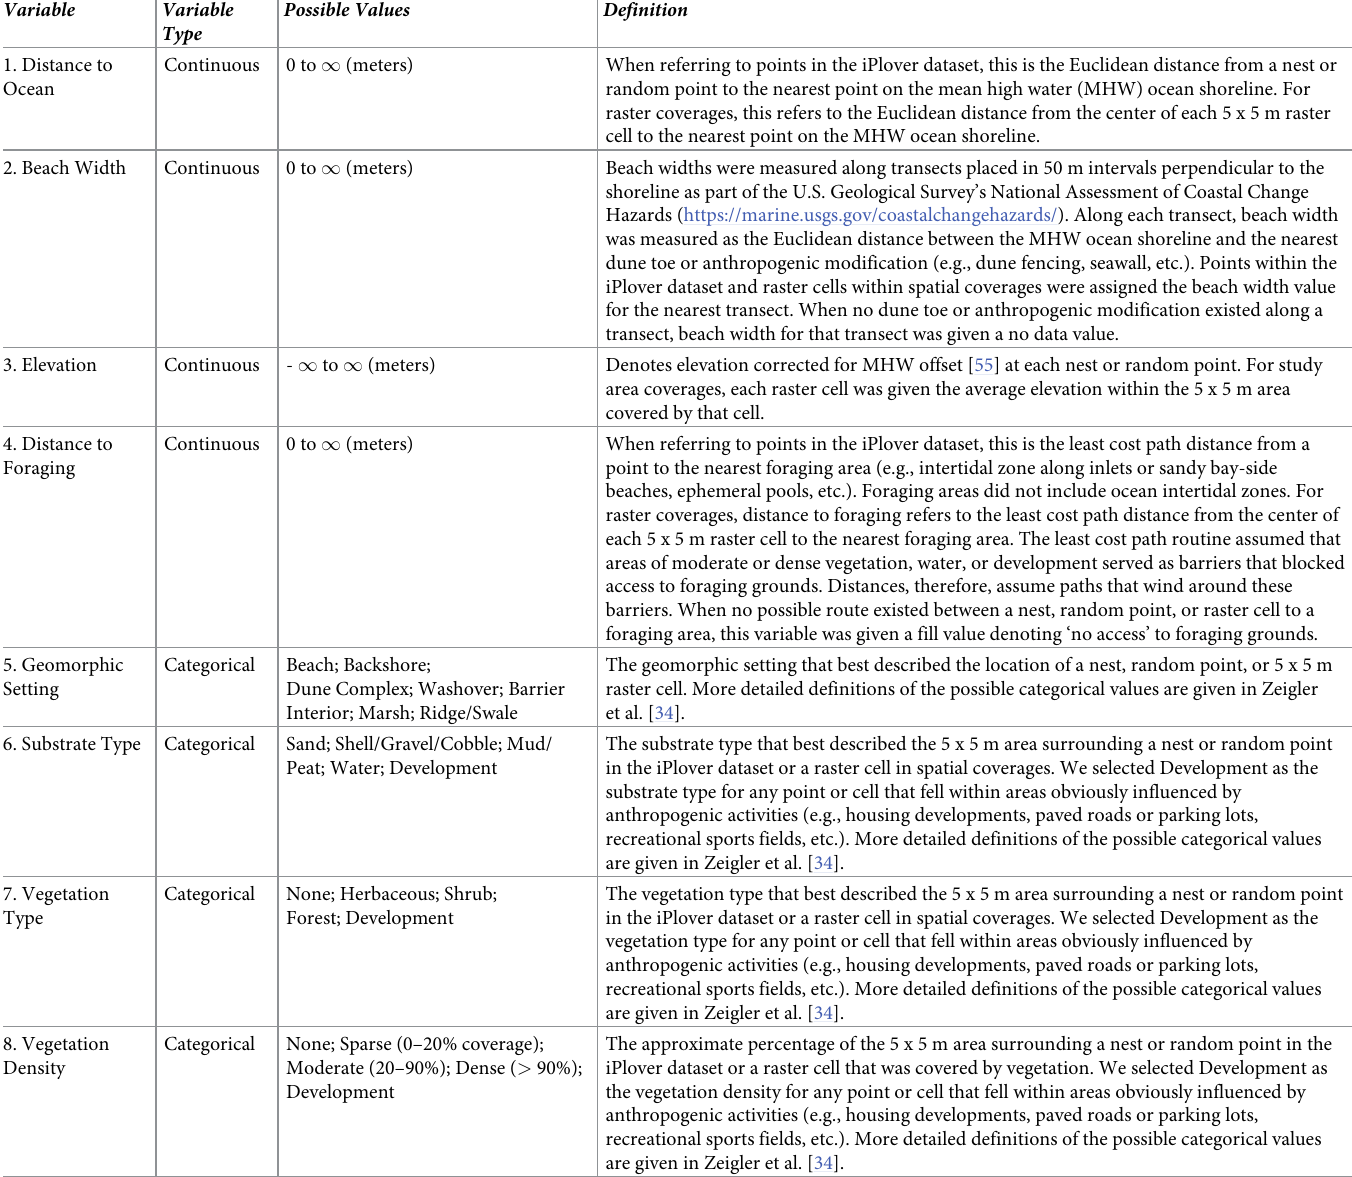
Table 1. Landscape variables considered as nodes in the Plover Habitat Bayesian network used to model habitat for piping plovers along the coasts of New York, New Jersey, and Virginia. Variables were associated with data collected at piping plover nest and random points through the smartphone application iPlover and were also individually mapped for our study areas. Continuous variables were discretized into bins shown in Fig